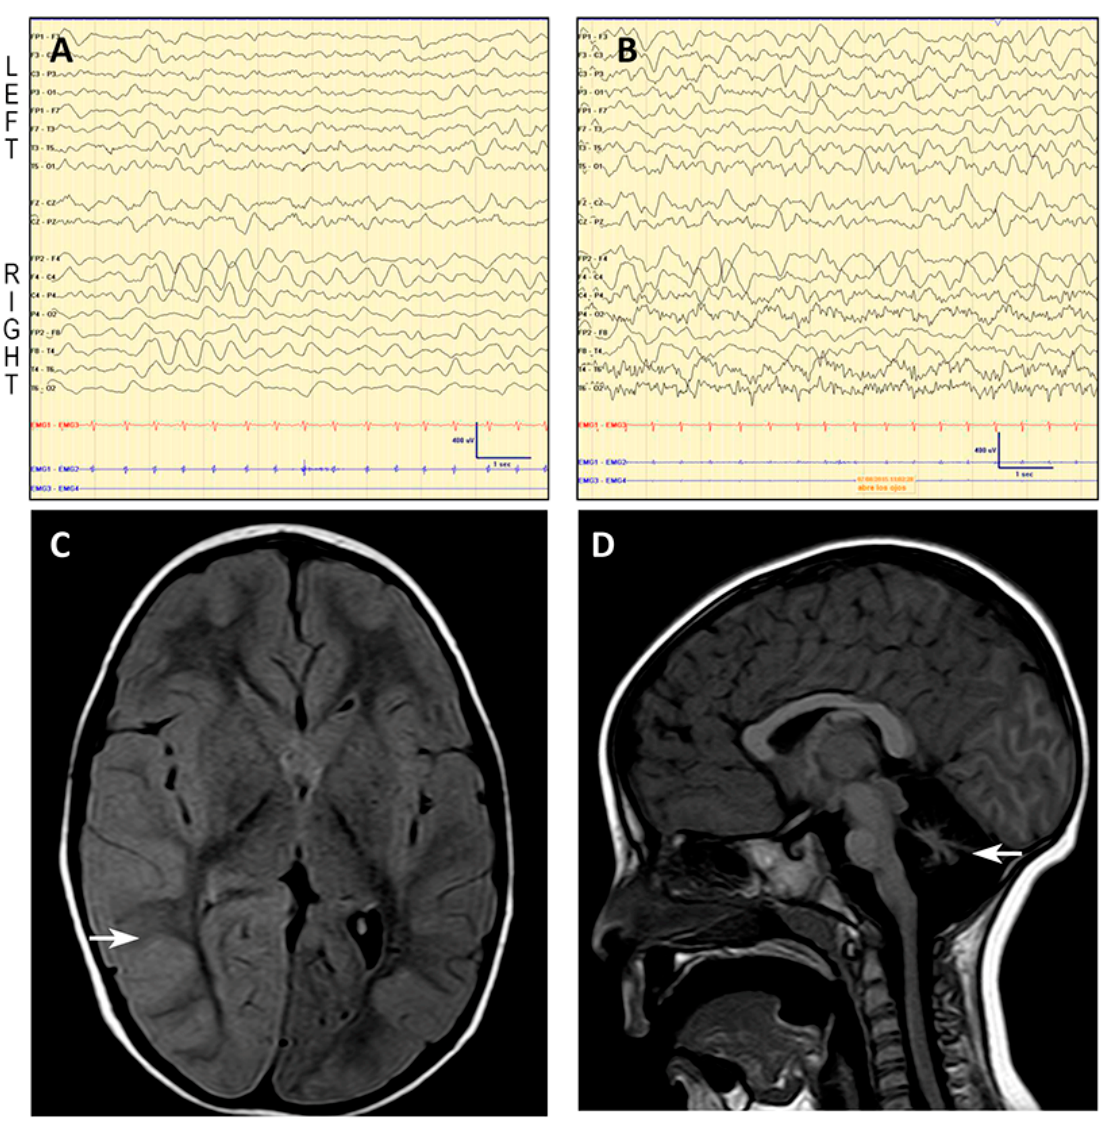
Figure 1. Patient 1: EEG and MRI. EEG shows asymmetric (right) slow background trace with moderately low voltage in temporal regions ( A , B ), and frontal intermittent rhythmic delta activity (FIRDA) in the right hemisphere, coherent with the edema found on the MRI and the left hemiparesis. Below, axial fluid attenuation inversion recovery (FLAIR) MR image reveals cortical diffuse edema in the right hemisphere, mainly in the parieto-occipital region ( C , see arrow). Midsagittal T1-weighted MR image of the same patient shows a small cerebellar vermis with enlarged interfolial spaces representing atrophy and secondary enlargement of the fourth ventricle ( D , see arrow).